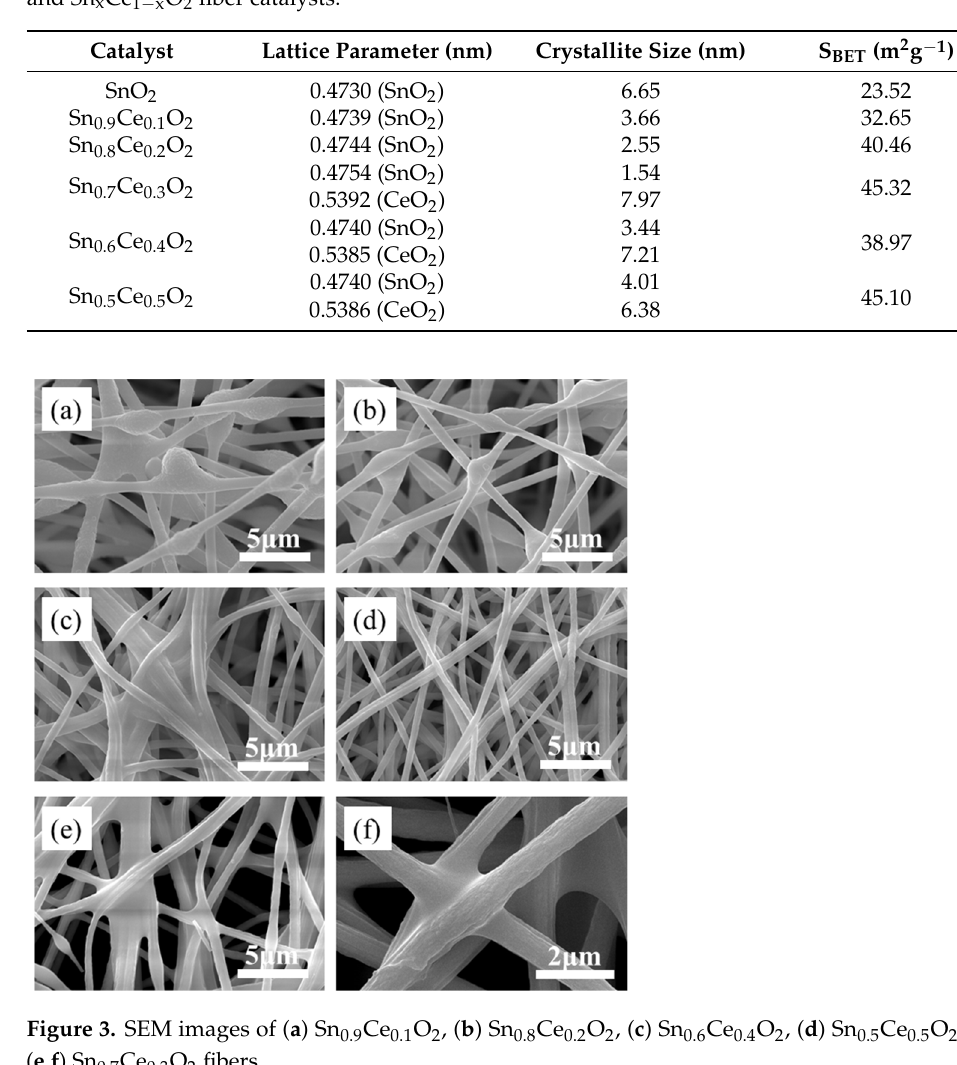
Figure 4. SEM-mapping images of ( a ) Sn 0.7 Ce 0.3 O 2 fibers, ( b ) Sn, ( c ) Ce, and ( d ) O.